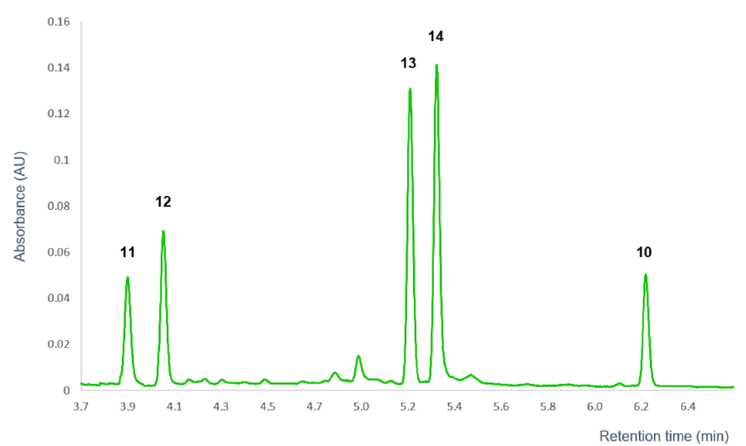
Figure 9. UPLC-DAD chromatogram of the decomposition products of 1′ S -1′-acetoxyeugenol acetate ( 10 ).